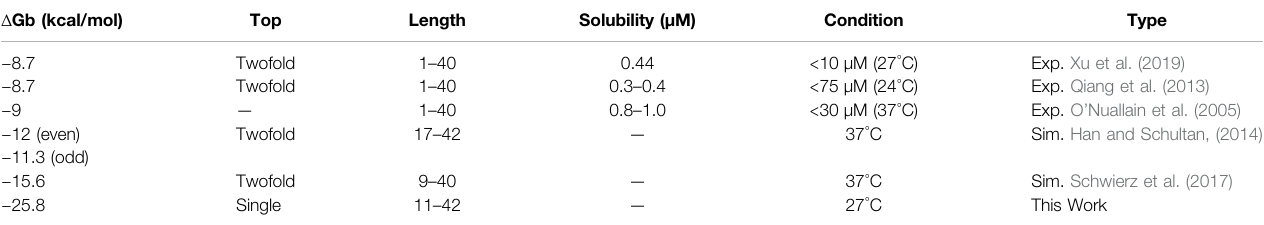
TABLE 1 | Thermodynamic binding af fi nity of Abeta binding to a fi